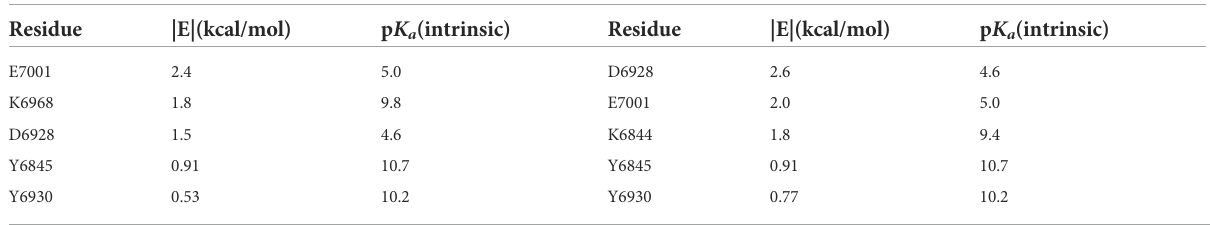
docking scores, and MM-GBSA scores, along with the speci fi c ligand-protein interactions. The docking score ranges for Extra mol. The interactions in the ligand-protein complex are shown in Supplementary Figure S4 and listed in Supplementary Table S2.